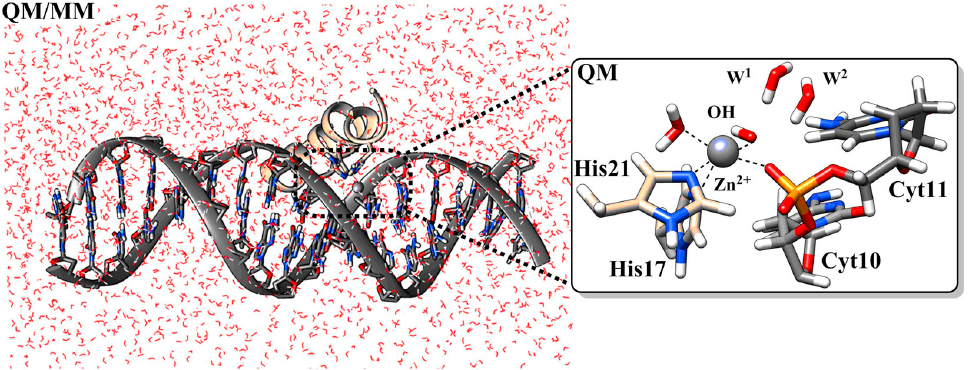
Figure 2. The MD-equilibrated structure of a ClavA-Zn(II) complex showing the initial step in the hydrolysis of DNA. Some hydrogen atoms and solvent water molecules were omitted for clarity. Nitrogen is shown in blue, phosphorus in orange, and oxygen in red. Reprinted with permission from Reference [12]. Copyright 2022, American Chemical Society.